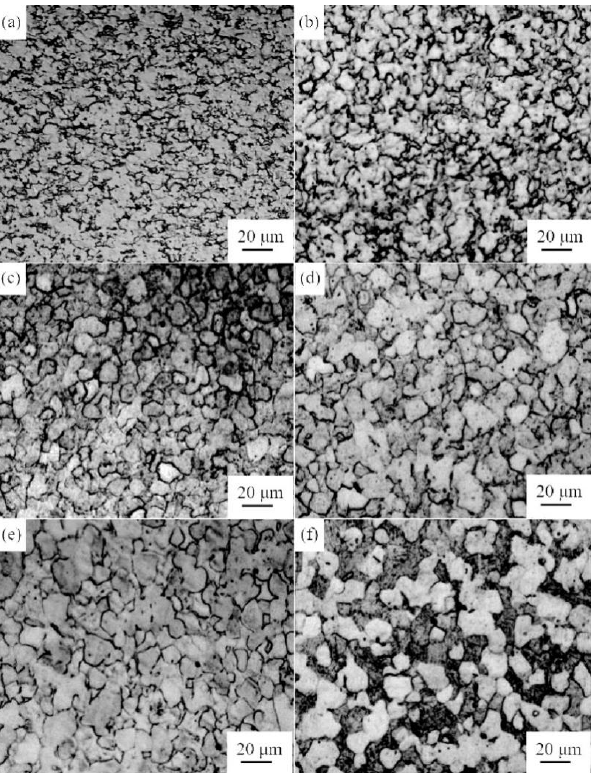
Figure 5. Microstructures of Ti-6Al-4V after superplastic deformation at different temperatures and strain rates: ( a ) 750 °C, 5 × 10 − 3 s − 1 ; ( b ) 750 °C, 10 − 3 s − 1 ; ( c ) 750 °C, 5 × 10 − 4 s − 1 ; ( d ) 810 °C, 5 × 10 − 3 s − 1 ; ( e ) 810 °C, 10 − 3 s − 1 ; ( f ) 810 °C, 5 × 10 − 4 s − 1 .